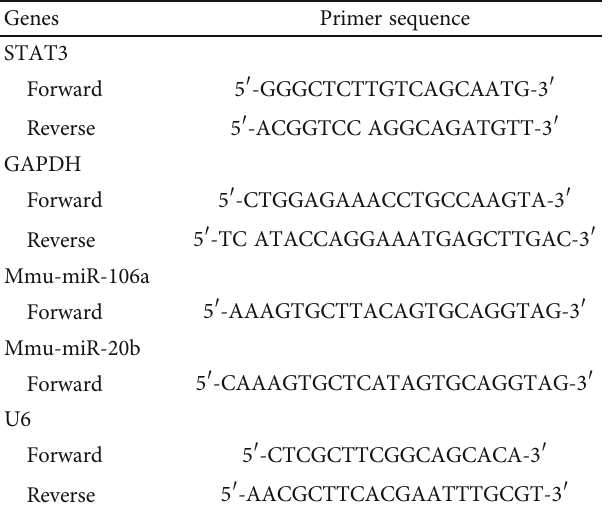
Table 1: Primers used for quantitative real-time